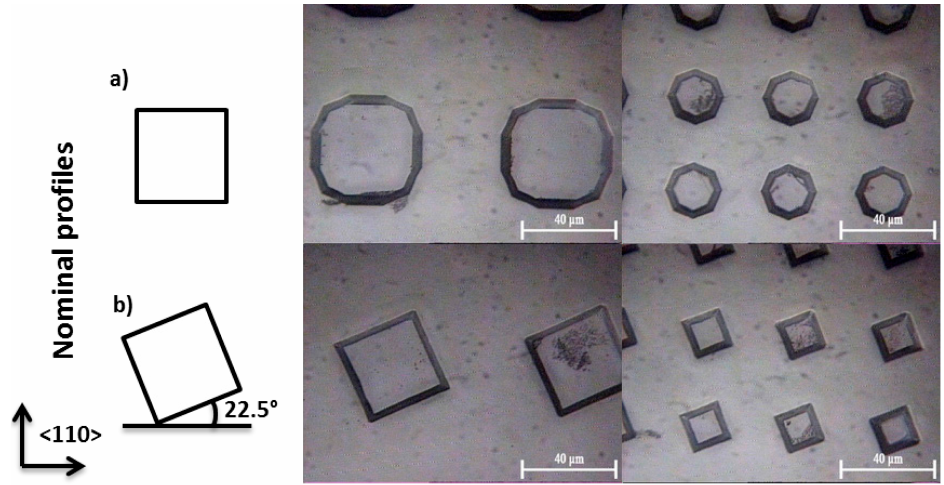
Figure 9. Microscopic inspection of a 22 wt % KOH wet etch process, (Sample 2, in Table 1) after 20 min. Initial profile: ( left ) 40 μm and ( right ) 20 μm; square: ( a ) aligned with the wafer flat; and ( b ) misaligned 22.5° with the wafer flat.